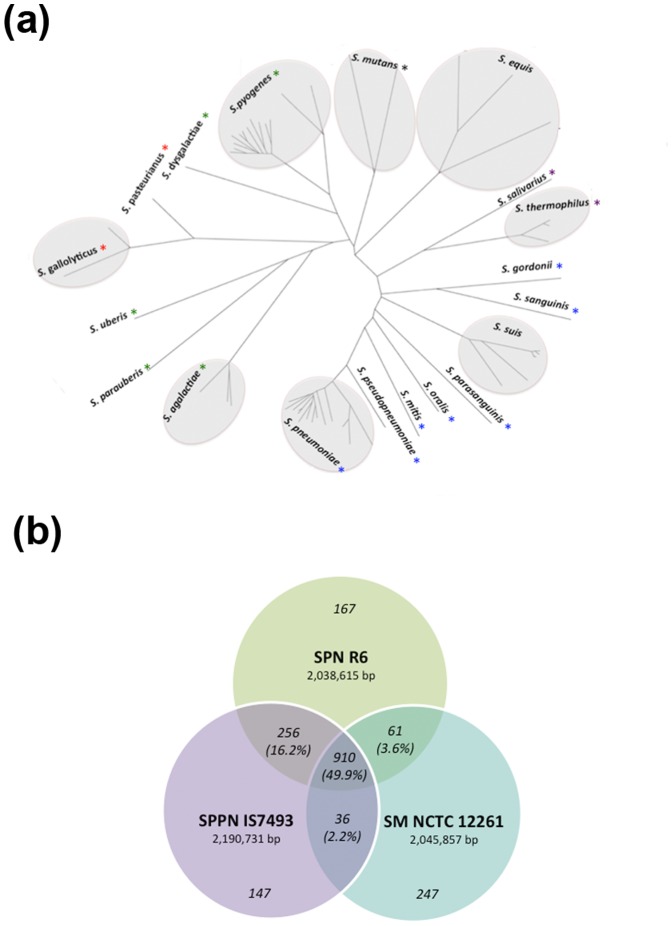
Comparative genome analysis of S .pseudopneumoniae IS7493 with the selected closely related streptococci.(s) Whole genome phylogenetic tree of selected VGS isolates (Neighbor joining) generated using CVTree [16]. The branch lengths are representative of phylogenetic distance. Color legend for asterisks: blue, Mitis group; black, Mutans group; purple, Thermophilus group; green, Pyogenic group; and red, Bovis group. (b) Summary statistics for the genome comparison of S. pseudopneumoniae IS7493 with the closely related S. pneumoniae R6 and S.mitis NCTC12261. The CDS that are not accounted for in this comparison coded for hypothetical proteins.